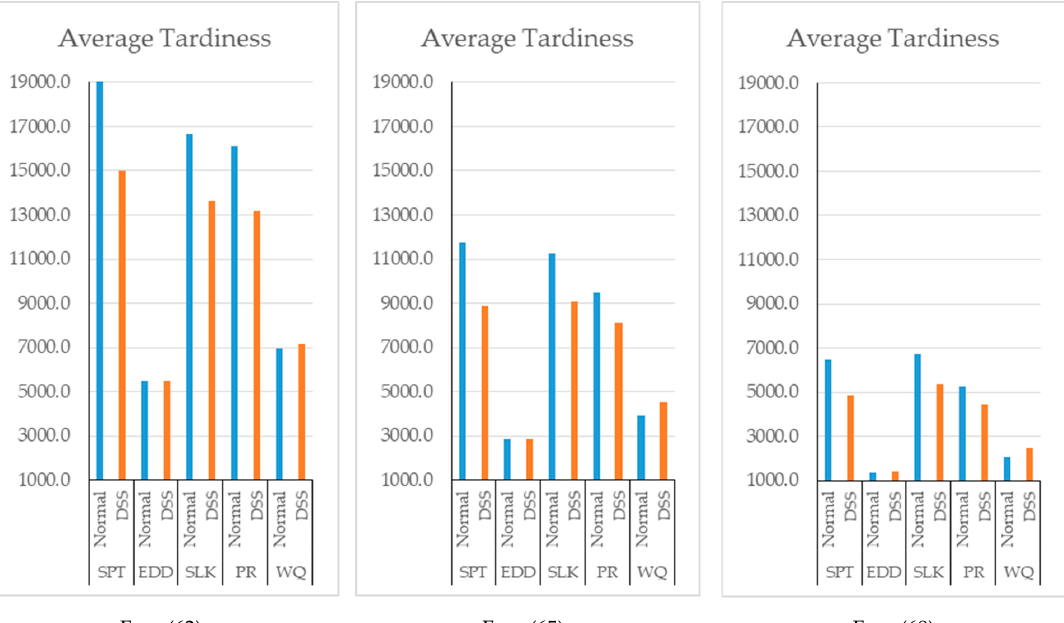
Figure 9. Average Tardiness.